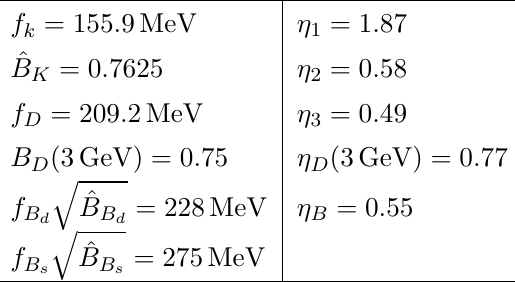
Table 2 . Central values of QCD input parameters used in the numerical analysis [49{52]. The DM scattering amplitudes o(cid:11) protons, f butions discussed in section 6. Denoting the contributions from the DM-up (down) quark coupling by a superscript u ( d ), we